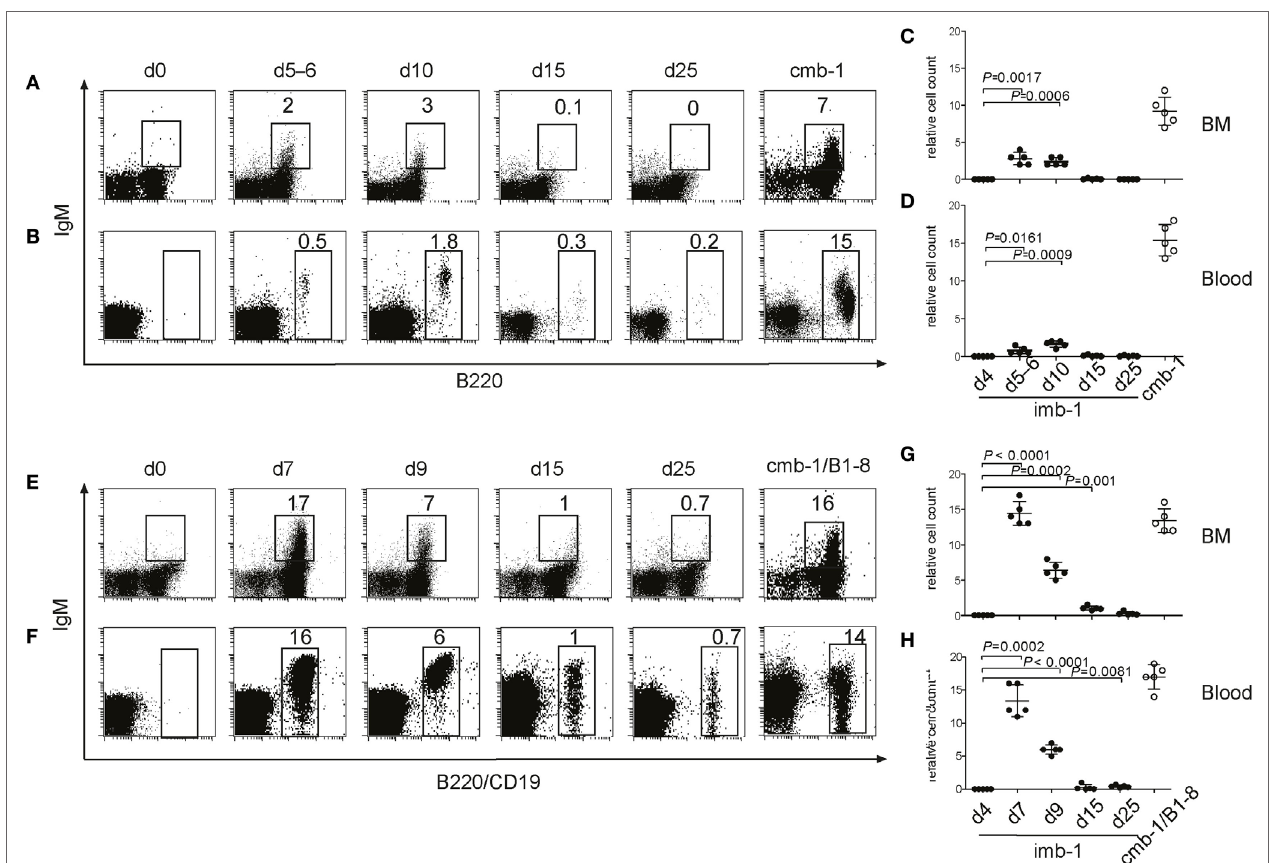
FigUre 2 | B-cell migration from the bone marrow (BM) into the secondary lymphoid organs of imb-1 mice takes place in a wave. (a,B) B220 versus IgM staining of total lymphocytes derived from BM (a) or blood (B) of imb-1 mice analyzed at different time points after a single treatment with tamoxifen [days 5–6, 10, 15, and 25 post induction (p.i.)]. Uninduced mice (d0) as well as cmb-1 mice served as controls. Representative data from three independent experiments with two mice at each time point are shown. (c,D) Statistical analysis of the relative cell count (percentage) of B220 + IgM + B cells (BM) or total B220 + B cells (blood) in the total lymphocyte gate of tamoxifen-treated imb-1 mice at days 4, 5–6, 10, 15, and 25. Mean ± SD of n = 5 is indicated for each time point; each dot represents an individual mouse. P values are indicated and were obtained using the one-sample t -test. (e,F) IgM versus B220 (upper panel; BM), or IgM versus CD19 (lower panel; blood) staining of total lymphocytes derived from the BM (e) and blood (F) , respectively, of imb-1/B1-8H (designated imb-1/B1-8) mice at indicated time points p.i. Uninduced mice (d0) as well as cmb-1/B1-8H mice served as controls. The percentages for B220 + IgM + (BM) and total CD19 + (blood) cells inside each box are indicated. Representative data from two independent experiments with two to three mice at each time point are shown. (g,h) Statistical analysis of the percentage of B220 + IgM + B cells (BM) or CD19 + B cells (blood) within the lymphocyte gate in tamoxifen-treated imb-1/B1-8H mice at days 4, 7, 9, 15, and 25. Mean ± SD of n = 5 is indicated for each time point; each dot represents an individual mouse. P values are indicated and were obtained using the one-sample t